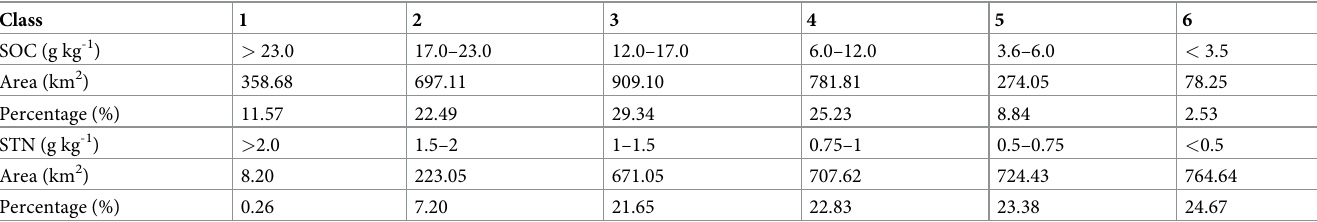
Table 3. Areas and percentages of soil organic carbon (SOC) and total nitrogen (STN) by different classes in Changting County.